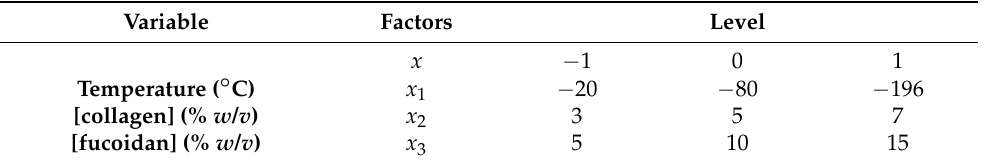
Table 2. Coded levels and the variables of the 3 3 Box–Behnken factorial design. Variable Factors Level x − 1 0 1 Temperature ( ◦ C) x 1 − 20 −